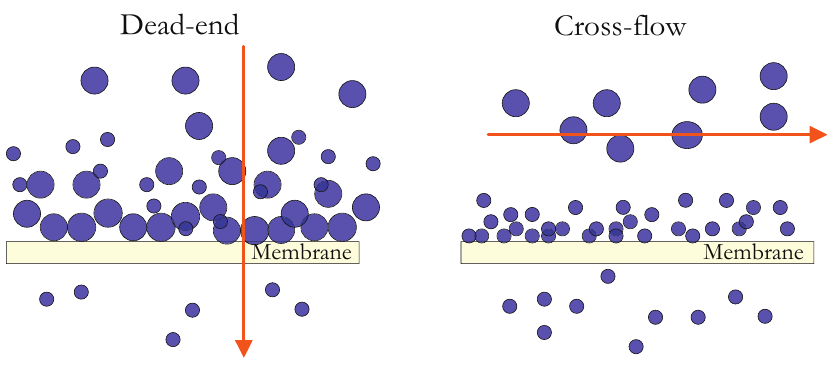
Figure 2. Filtration modes: dead-end and